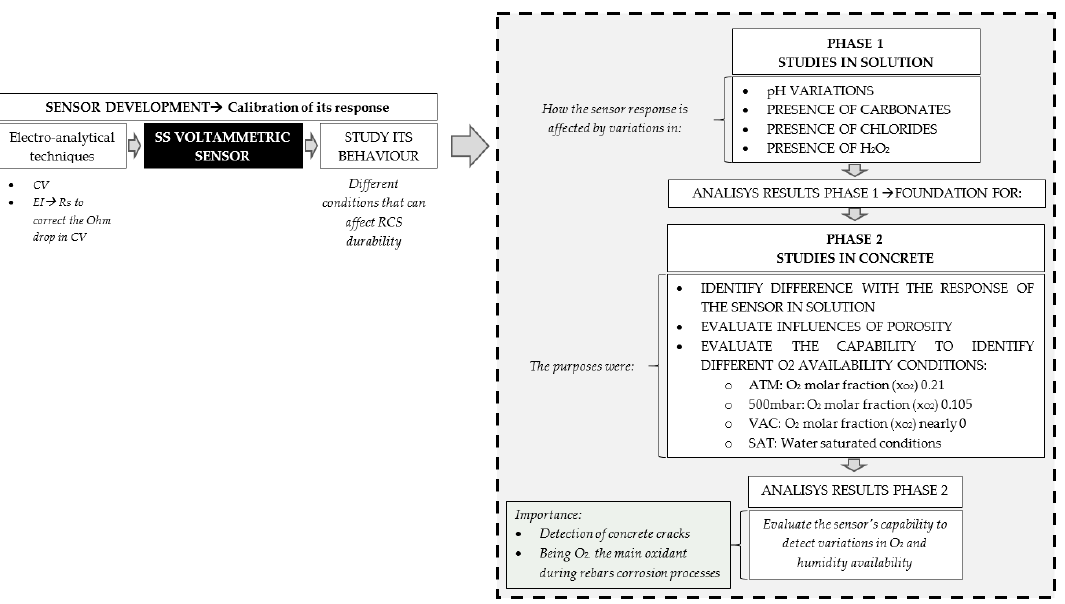
Figure 4. Scheme of the mechanism for the experimental results.